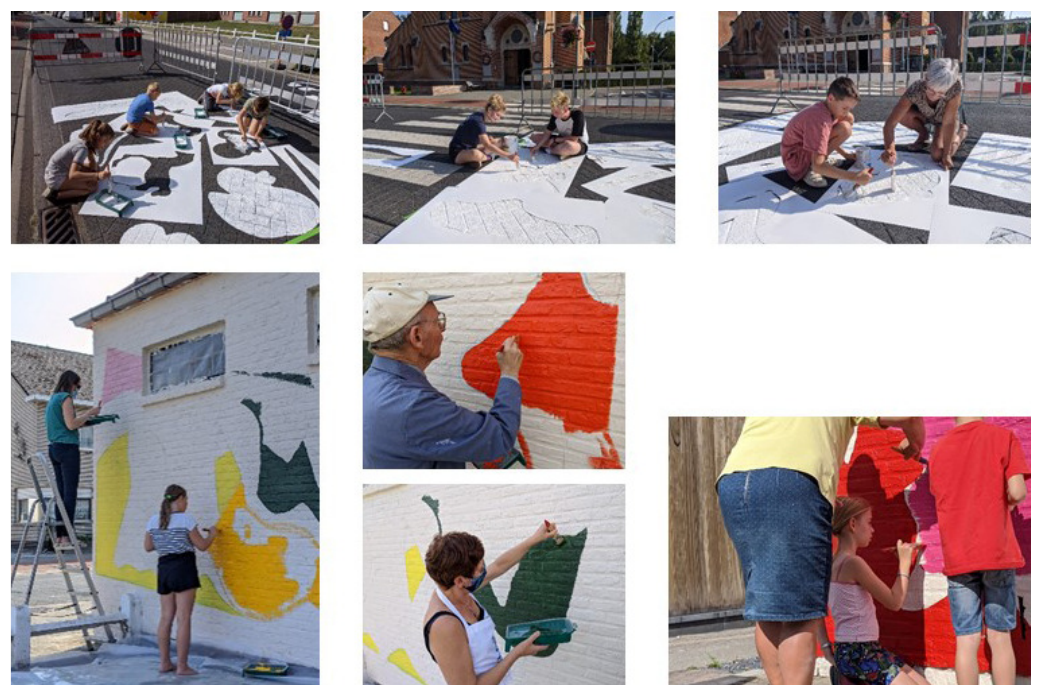
Figure 4. Implementation and results of the Colour and Shape Heist‐Goor artistic trajectory in a characteristic public space of Heist‐Goor. Source: Ruth Segers.